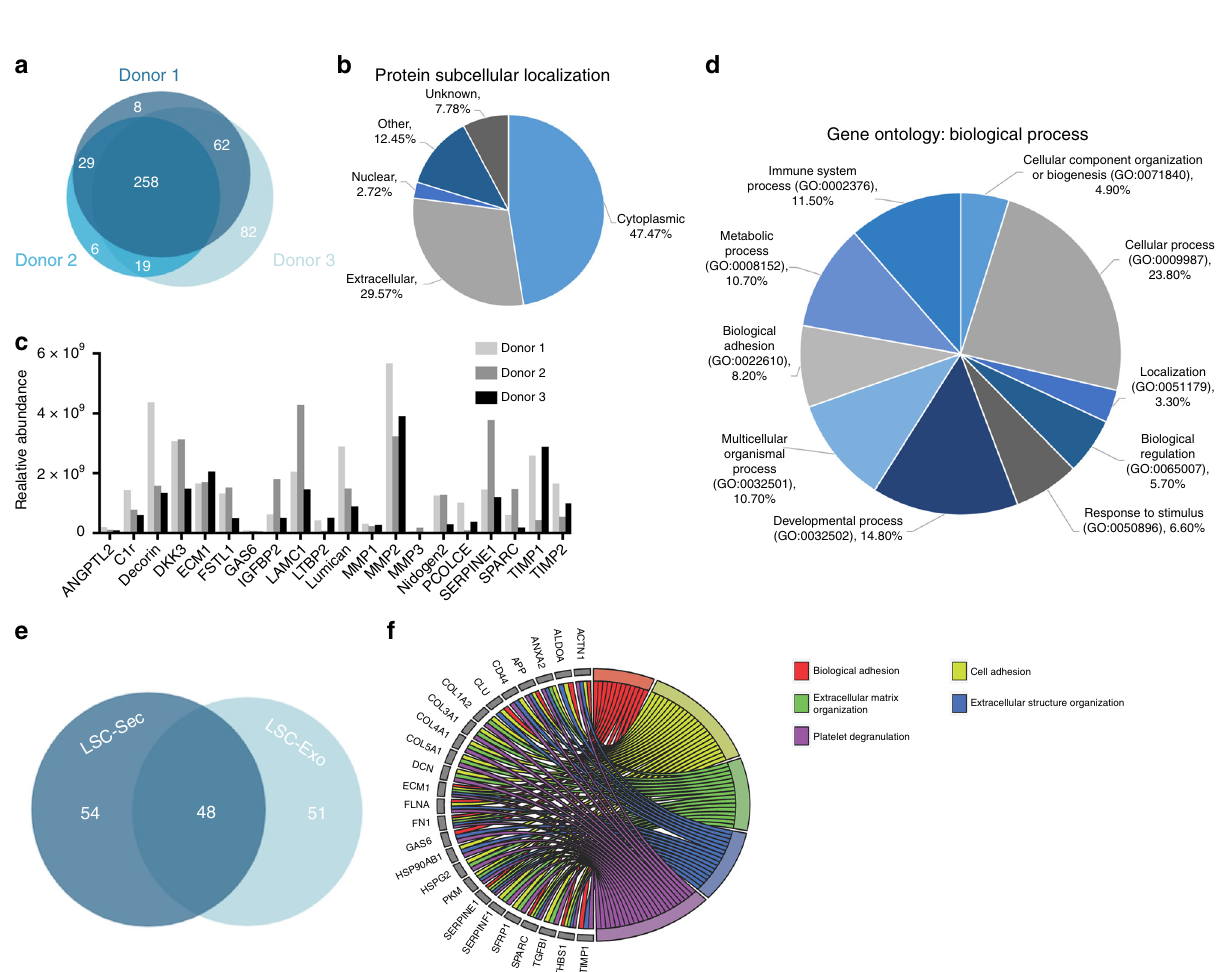
Fig. 4 Proteomic analysis of LSC-Sec and LSC-Exo. a Venn diagram of proteins identi fi ed in LSC-Sec derived from three donors. b Pie chart of protein subcellular location of all common proteins in all three LSC-Sec. c Relative abundance of 20 of the 103 extracellular proteins identi fi ed in all three LSC-Sec. d Gene ontology pie chart of biological process associated with the shared extracellular proteins. e Venn diagram of extracellular proteins identi fi ed in LSC- Sec versus LSC-Exo. f Gene ontology chord chart of biology process associated with the shared LSC-Exo proteome consisted of cytoplasmic proteins (65%) and only 5% of extracellular proteins. When comparing the cytoplasmic proteins detected in the LSC-Sec with the lysed cells, we found that only 56 out of 222 proteins (~25%) classi fi ed as cytoplasmic proteins in the secretome could be from potentially lysed or dead cells. These fi ndings suggest that the other ~75% of the proteins annotated as cytoplasmic proteins identi fi ed in LSC-Sec are proteins that are released from the cells via a mechanism or pathway that is currently unknown.